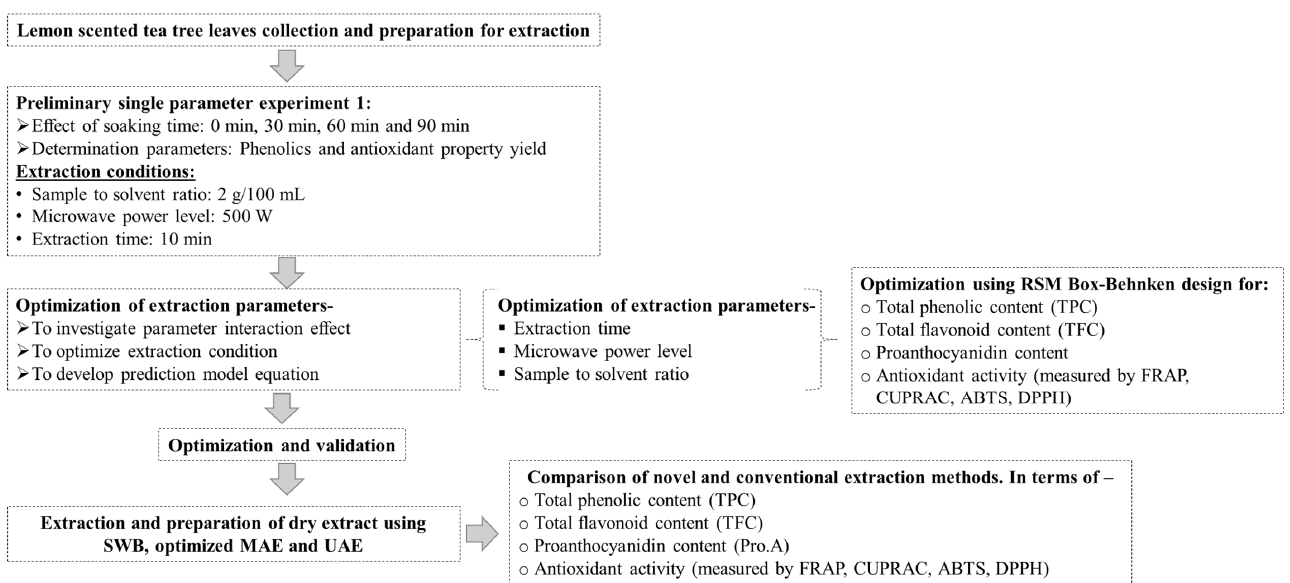
Figure 2. Experimental flow diagram for the study. Here, Ferric reducing antioxidant power (FRAP), Cupric ion reducing antioxidant capacity (CUPRAC), ABTS radical scavenging assay (ABTS), DPPH free radical scavenging assay (DPPH). Table 1. Box–Behnken design and observed responses for optimized MAE extraction of polyphenols and antioxidants properties from lemon-scented tea tree.